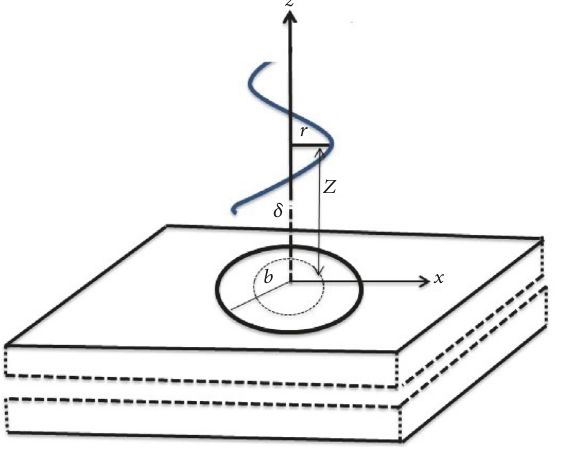
Figure 2: An ssDNA molecule penetrating a lipid bilayer